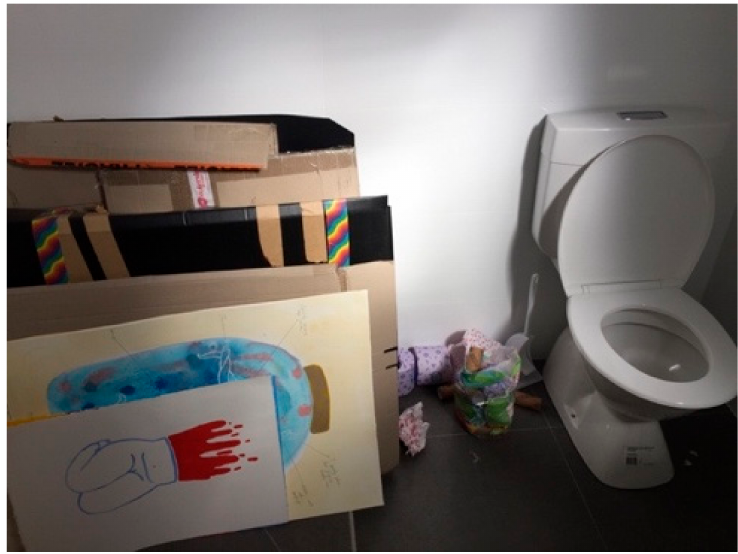
Figure 9. Discarded. Canvases on the floor in Frances’s Studio. RMIT University Human Ethics Clearance Number